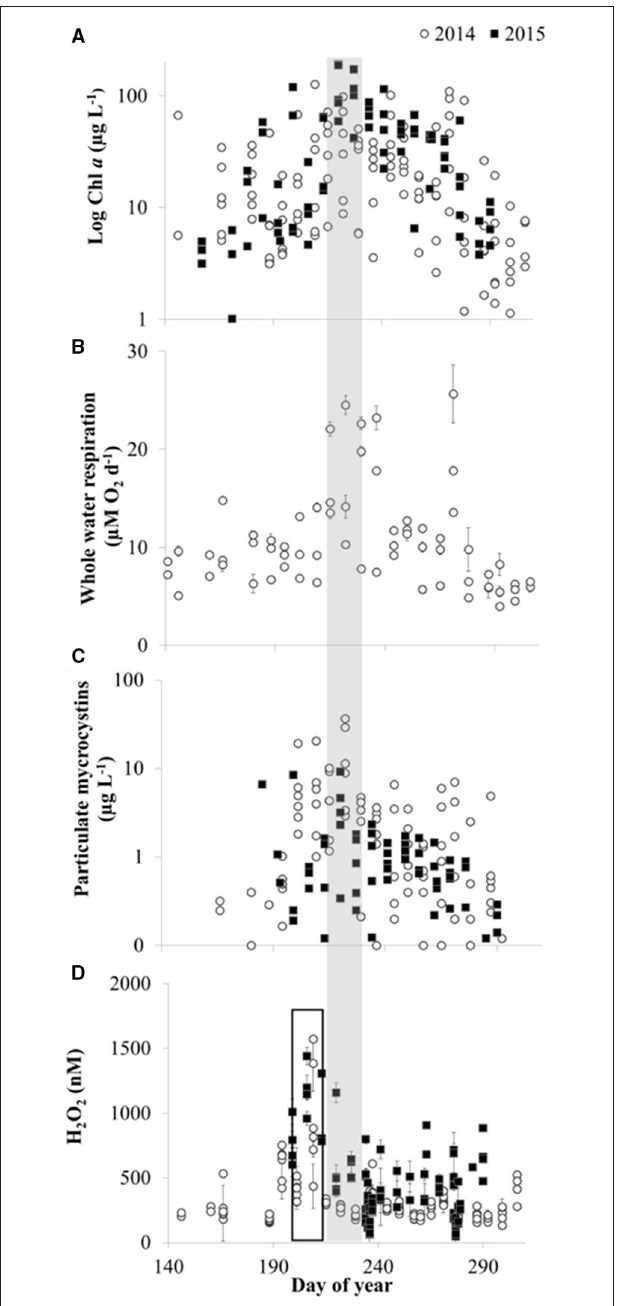
FIGURE 10 | Temporal patterns in biological activity and H 2 O 2 in Lake Erie. (A) Chlorophyll a (Chl a ) concentrations. (B) Whole water respiration rates (average ± SE, n = 3 ). (C) Concentration of particulate microcystins. (D) H 2 O 2 concentrations (average ± SE, n = 4 ). The shaded bar indicates the time of peak Chl a , whole water respiration, and particulate microcystins, while the open bar indicates the earlier peak in H 2 O 2 concentrations.